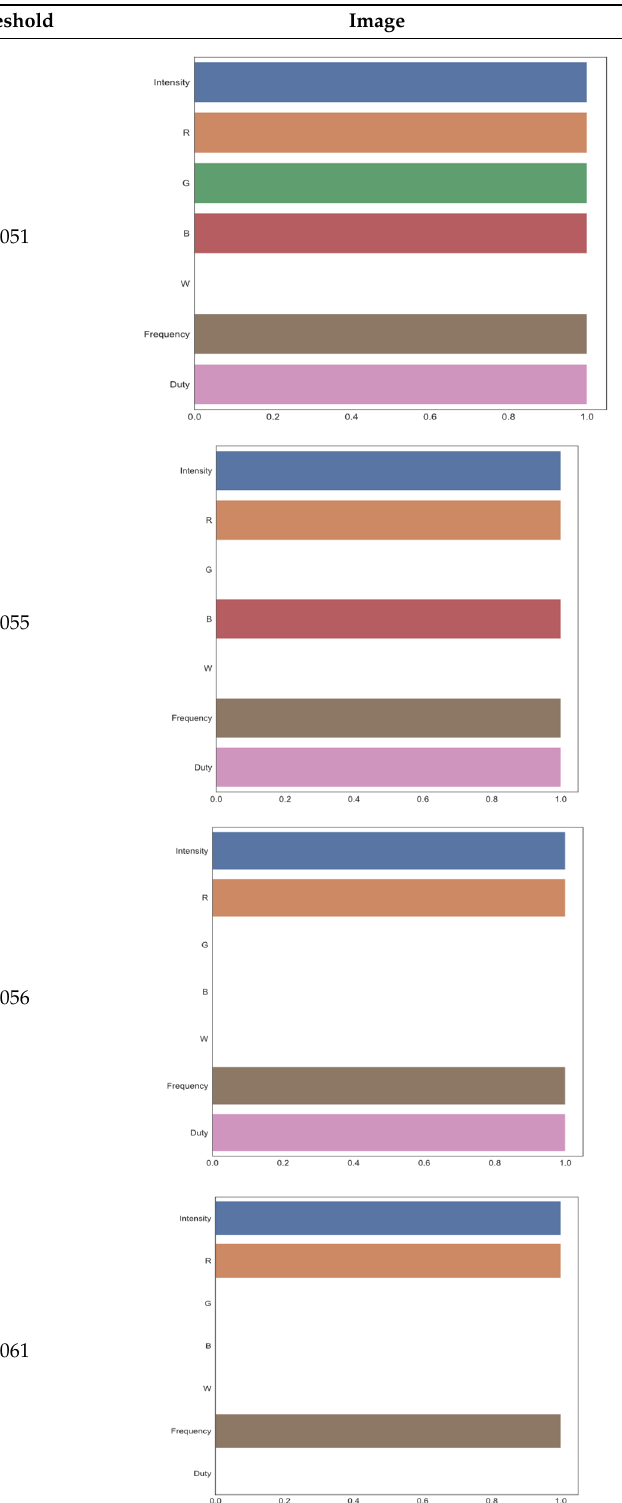
Table 4. Elimination order for features using variance threshold selection.